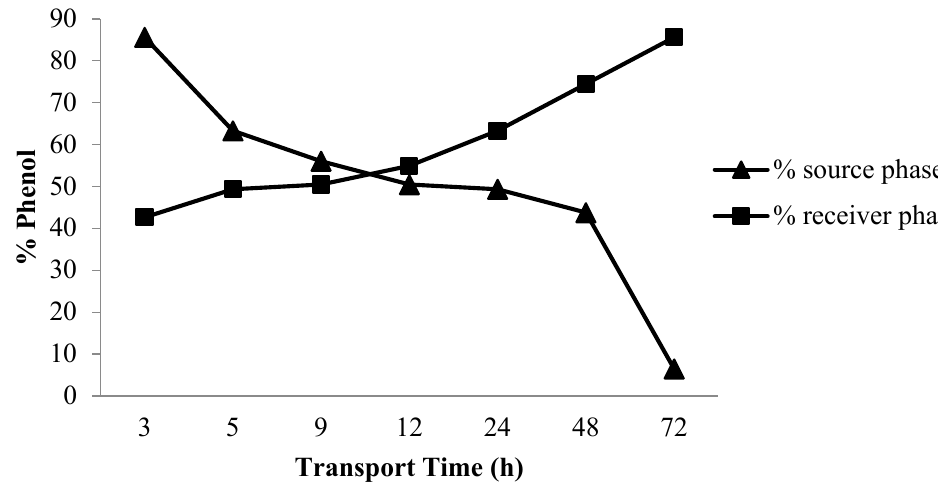
Figure 4. The phenol transport curve on the influence of time.